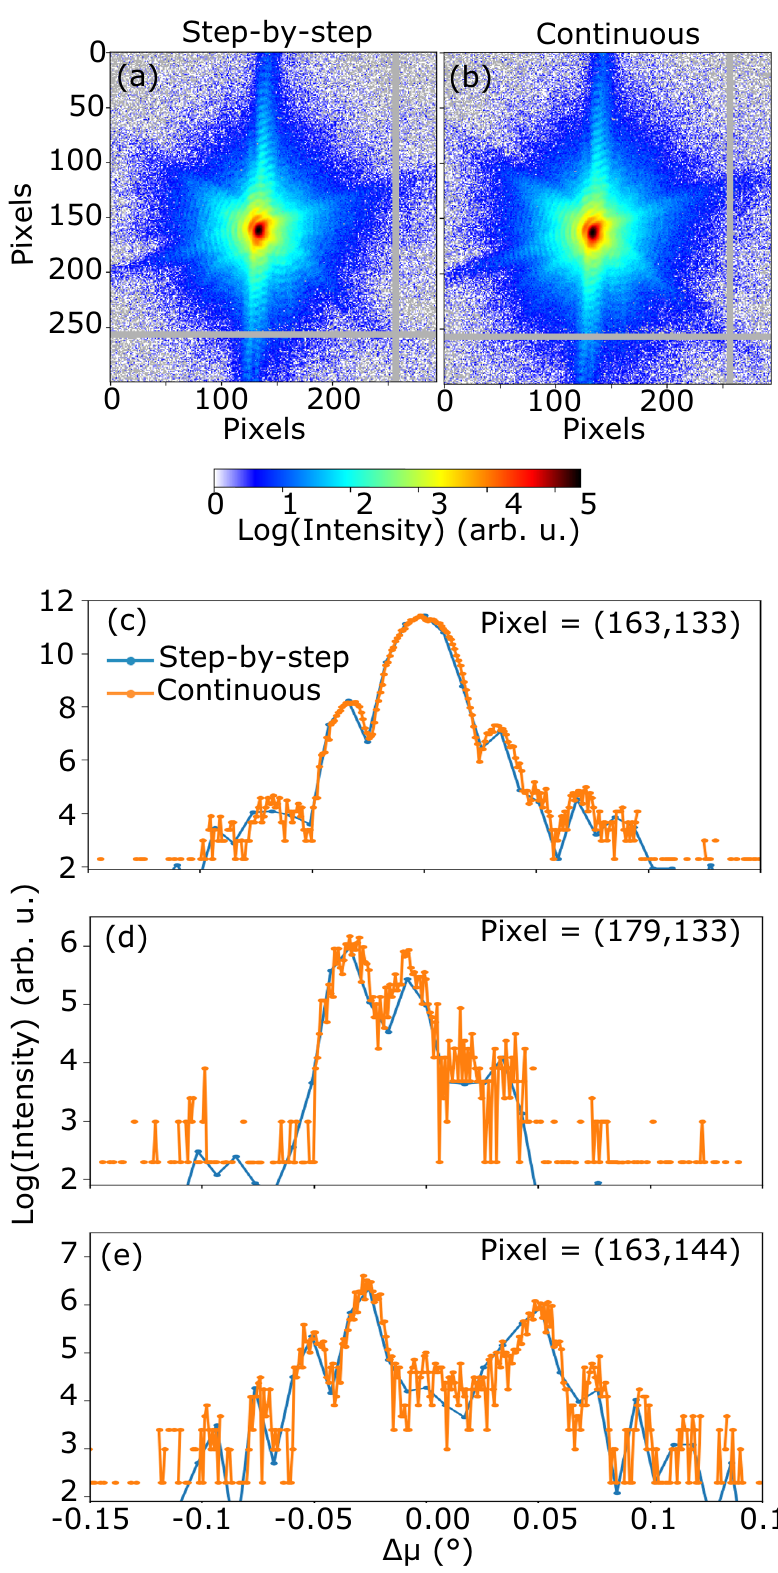
Figure 1. Comparison of intensity. Sum along the rocking direction of all the detector images acquired in the vicinity of the ¯ 111 Pt reflection during ( a ) step-by-step and ( b ) continuous scanning for the same Pt particle. The data is cropped on a region of interest of the detector centered on the diffraction pattern. The grey area correspond to the detector gaps. Evolution of the measured intensity during step-by-step and continuous scanning (with a scaling factor of 10 for the intensity measured during continuous scanning) as a function of the rocking-angle and at different pixels of the 2D detector: ( c ) at pixel = (163, 133)— which corresponds to the maximum of the intensity, ( d ) at pixel = (179, 133) and ( e ) at pixel = (163,